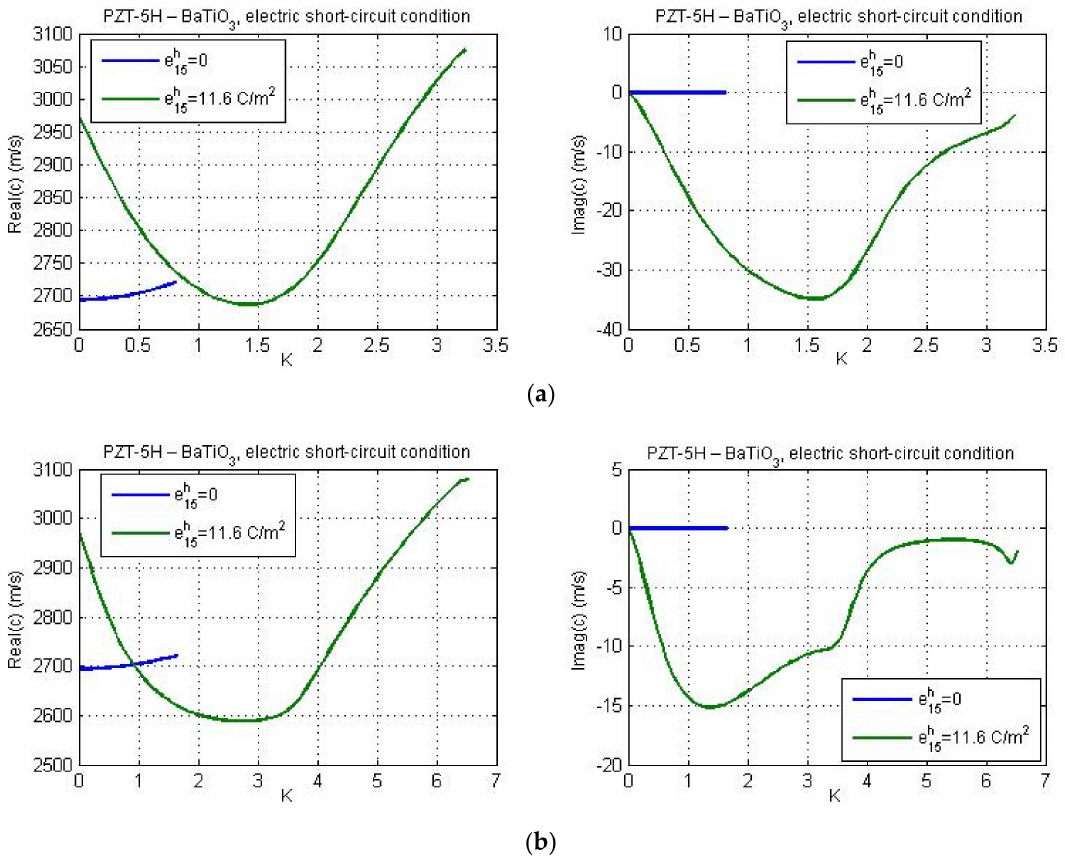
Figure 13. The dispersion curves for the material combination PZT-5H—BaTiO 3 with and without considering the effect of piezoelectric properties of the substrate under electric short-circuit conditions and for guiding layer thickness: ( a ) h = 20 nm and ( b ) h = 40